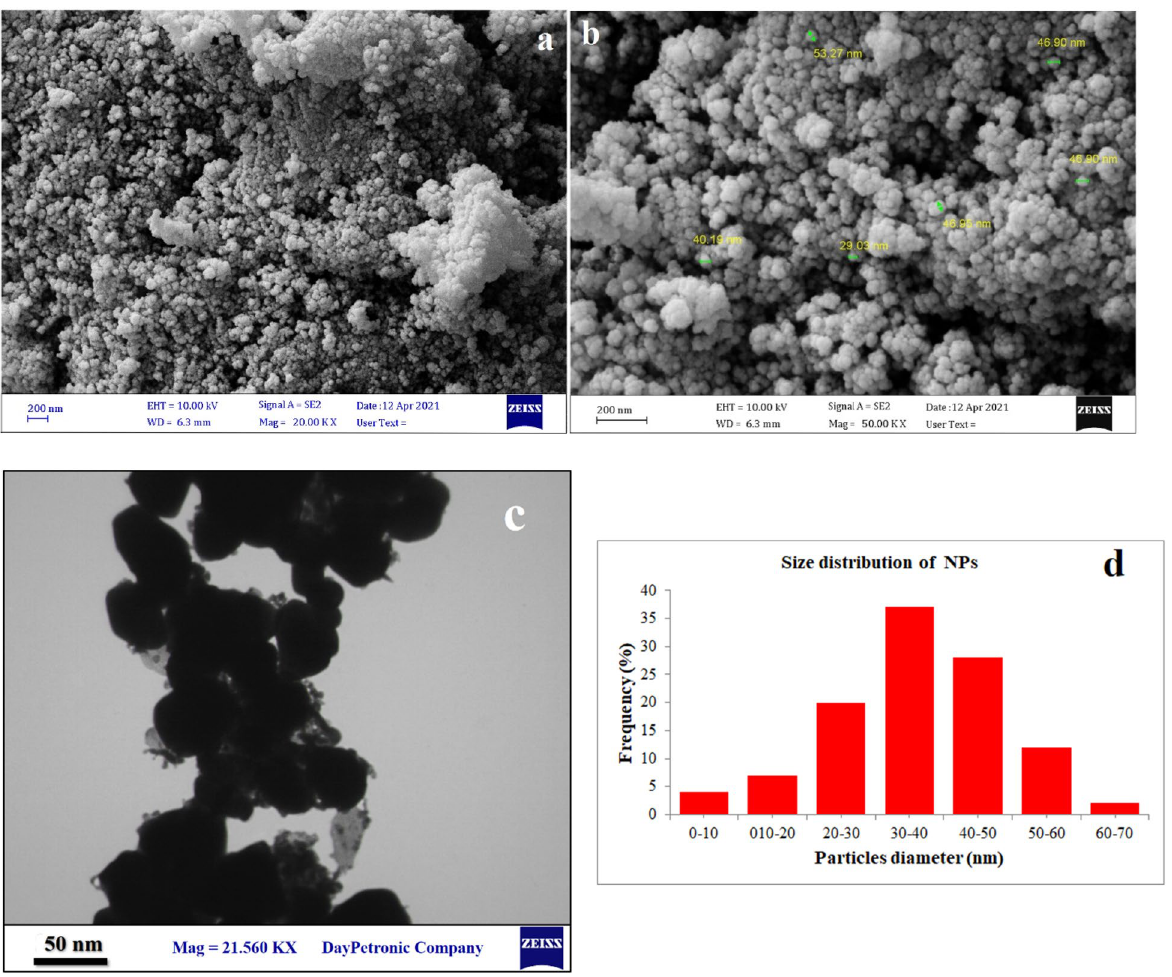
Figure 3. SEM ( a , b ), and TEM ( c ) images of Bi 2 O 3 /Gln-TSC NPs. ( d ) Particle size distribution of synthesized